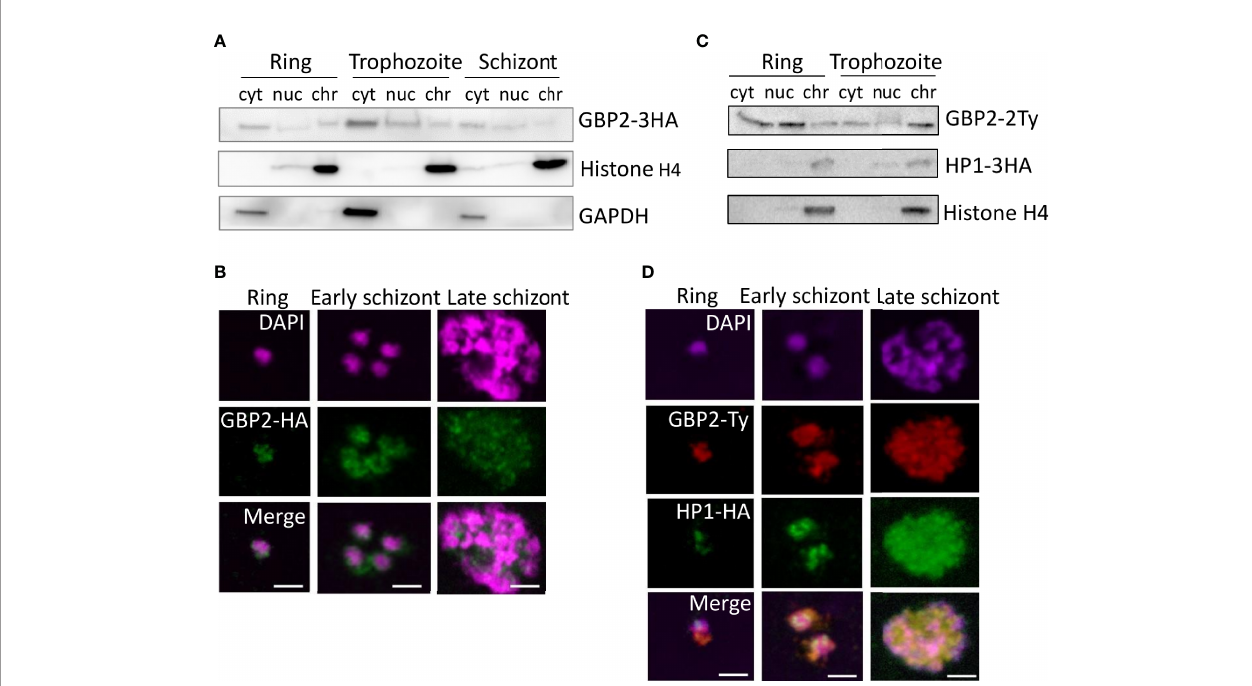
FIGURE 5 | Pf GBP2 is found in both the nucleus and cytoplasm in erythrocytic parasites. (A) Western blot of protein fractions (cyt, cytoplasm; nuc, nucleoplasm; chr, chromatin-bound) from ring, trophozoite and schizont 3D7 parasites expressing Pf GBP2-3HA. Parallel control blots show histone H4 (nuclear) and glyceraldehyde 3-phosphate dehydrogenase (GAPDH, cytoplasmic). Images are representative of several independent fractionation experiments. (B) Representative immuno fl uorescence images of ring, trophozoite and schizont 3D7 parasites expressing Pf GBP2-3HA, stained with an antibody against the HA tag and DAPI to identify parasite nuclei. Scale bar, 2 m m. (C) Western blots as in (A) 3D7 parasites expressing Pf GBP2-2Ty and HP1-3HA. (D) Representative immuno fl uorescence images as in (B) , parasites expressing Pf GBP2-2Ty and